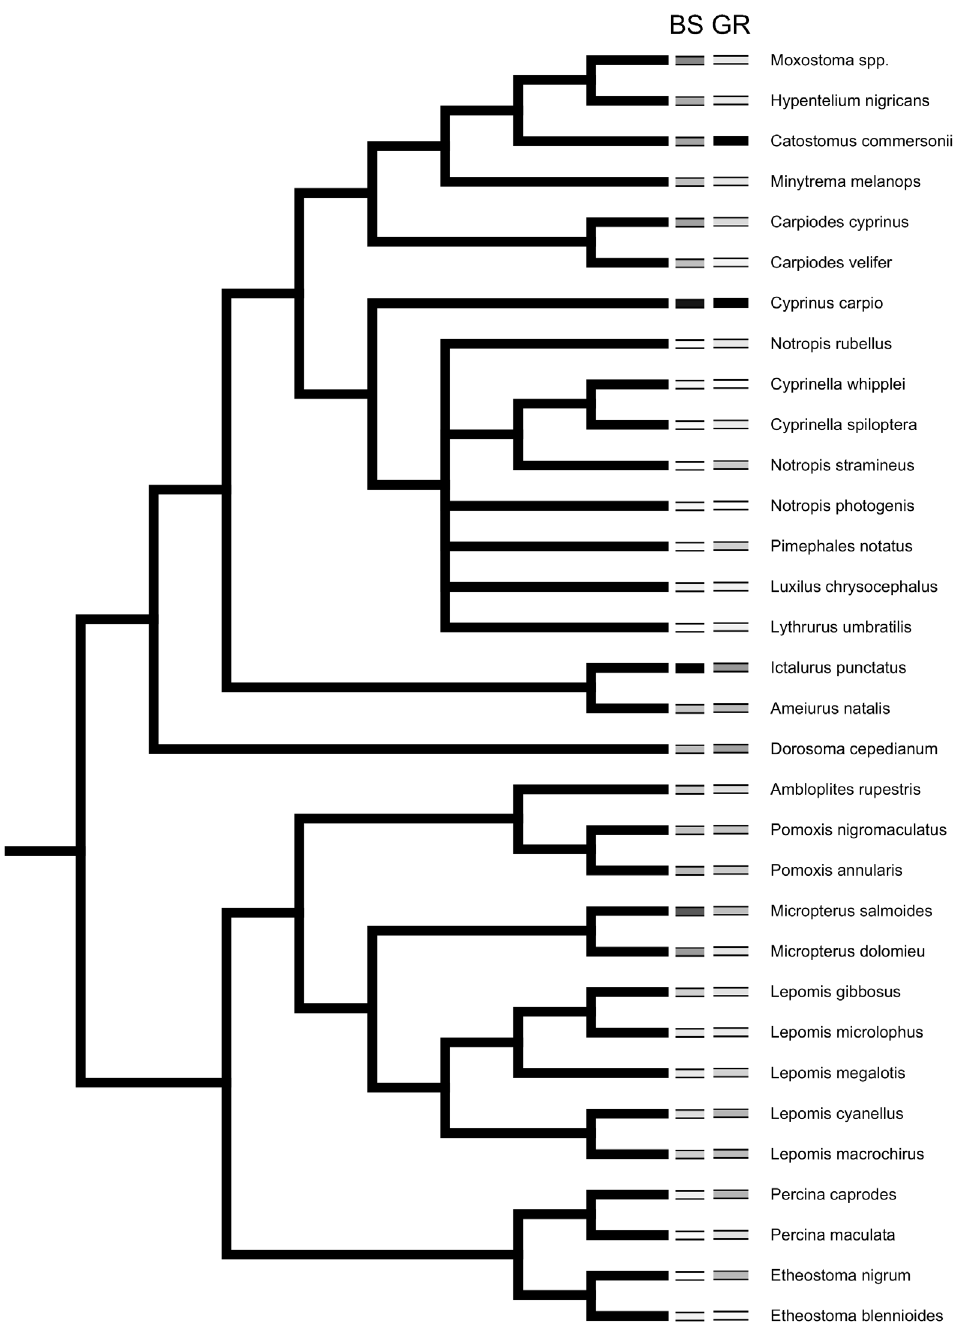
Figure 1. Phylogeny of study taxa with body size (BS) and geographic range (GR) categories. Darker bars indicate higher values. See Table 1 for raw data values.